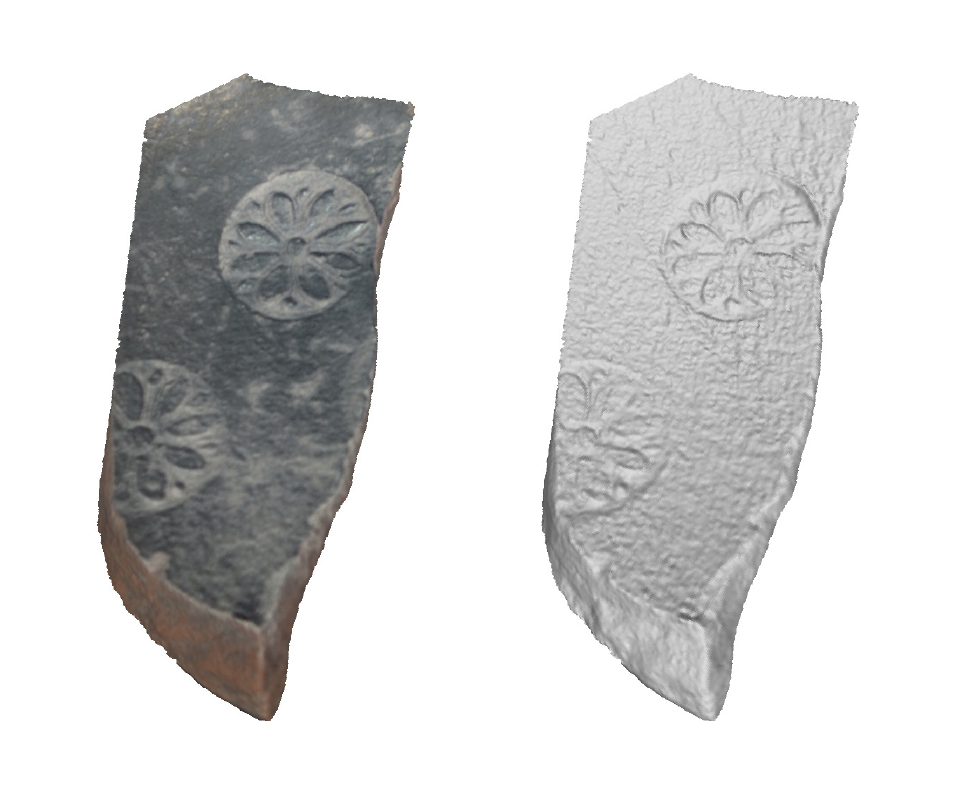
Figure 7. Scan result from the NextEngine UltraHD. Illustration by L.